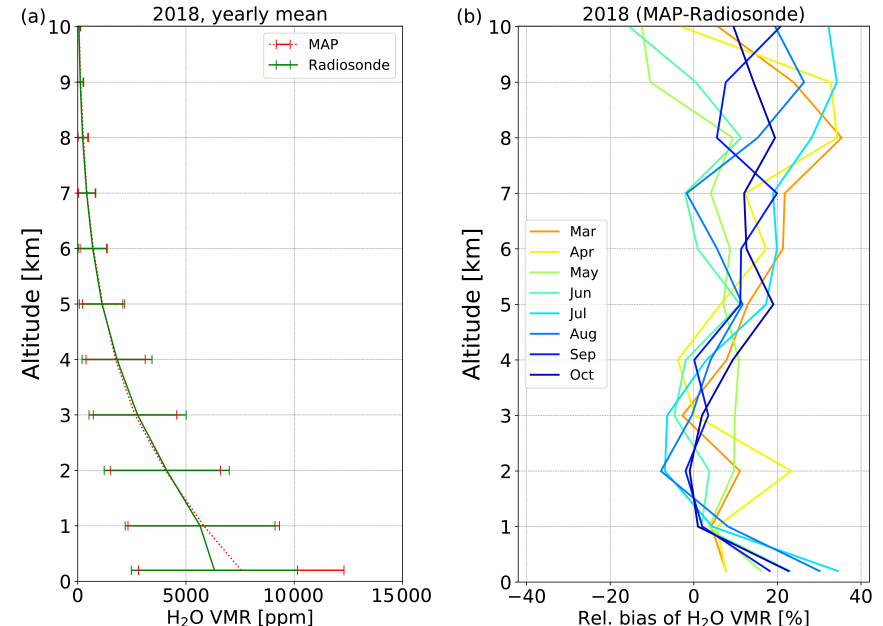
Figure 7. (a) Yearly averaged H 2 O VMR profiles as a function of altitude retrieved from MAP (in red) and the Vaisala RS41 radiosondes (in green) around noon at the Sodankylä site in 2018 (the error bar denotes the standard deviation). (b) The corresponding monthly averaged relative bias between MAP and radiosonde profiles. Vaisala RS41 radiosonde profiles are regridded to the vertical resolution of MAP profiles.